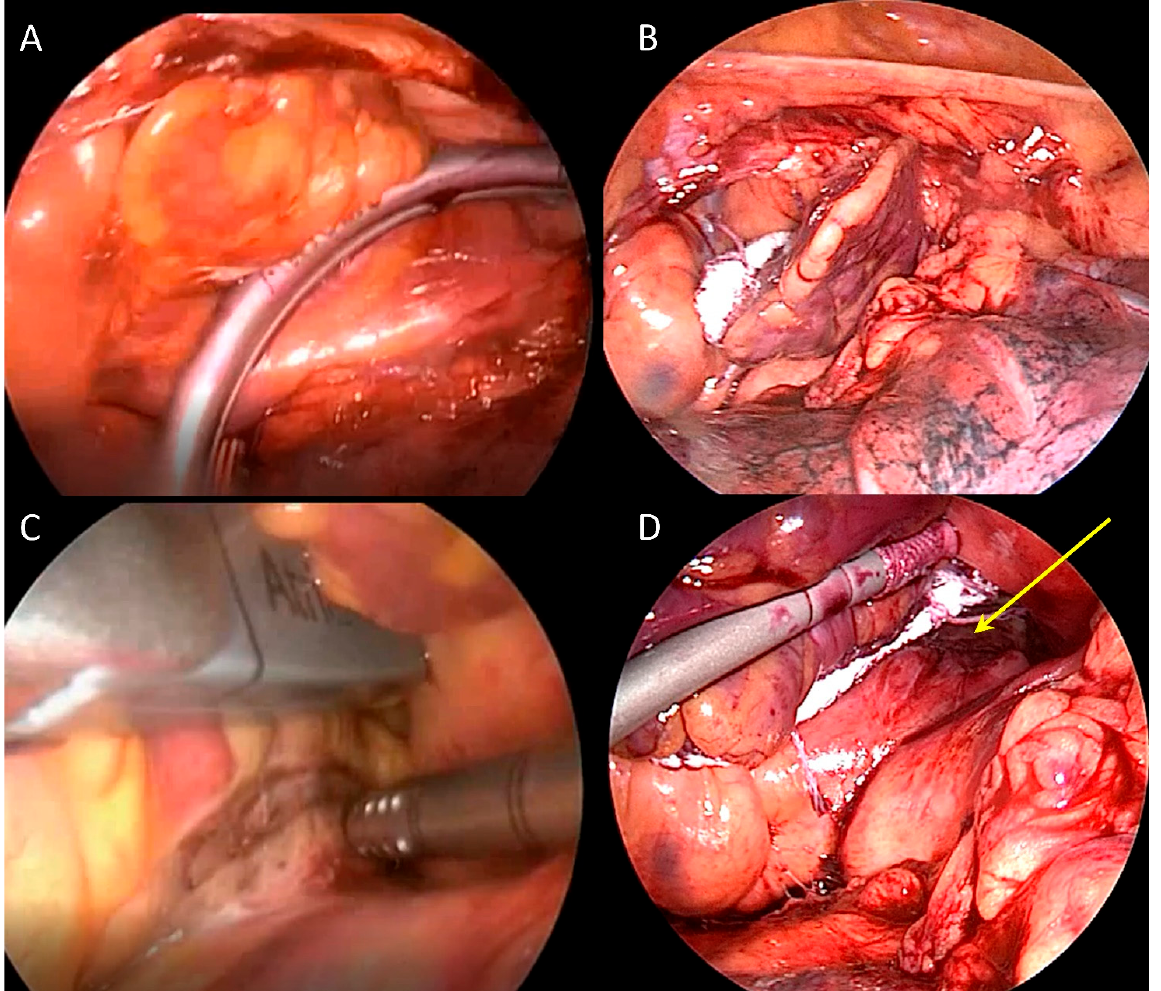
Figure 2. Hybrid AF ablation thoracoscopic access. Panel ( A ): left pulmonary veins isolation with the clamp (Synergy System; Atricure; West Chester, OH, USA); Panel ( B ): left atrial appendage closure with the clip (Atriclip, Atricure, West Chester, OH, USA); Panel ( C ): roof line with linear radiofrequency probe (Coolrail; Atricure, West Chester, OH, USA); Panel ( D ): ablation line between the clip and left pulmonary veins (yellow arrow).